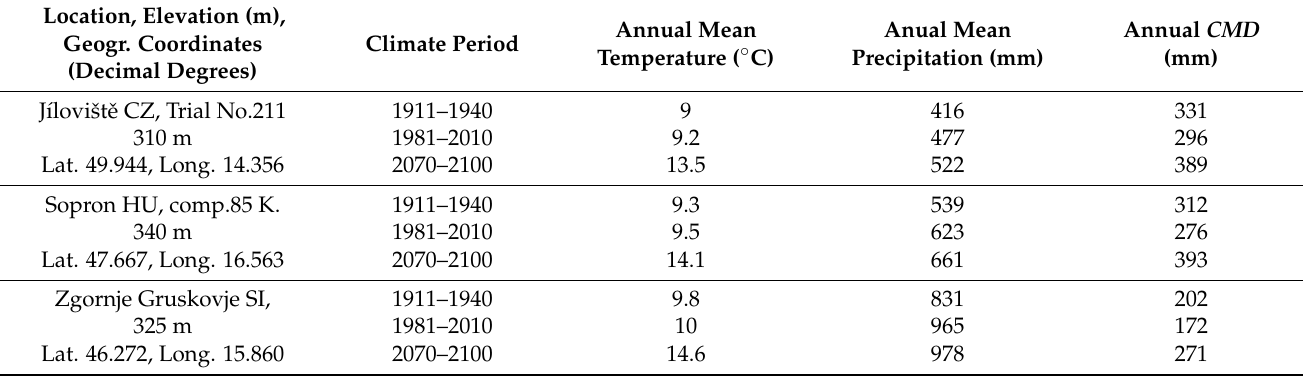
Table 6. Past, “current” and projected future climate data for selected locations in the Czech Republic, Hungary and Slovenia considered as xeric/rear limits of silver fir distribution at low elevations in Central-Eastern Europe (source of climate data: ClimateEU , projected pathway RCP8.5; for comparison with test site conditions see also Table A2).